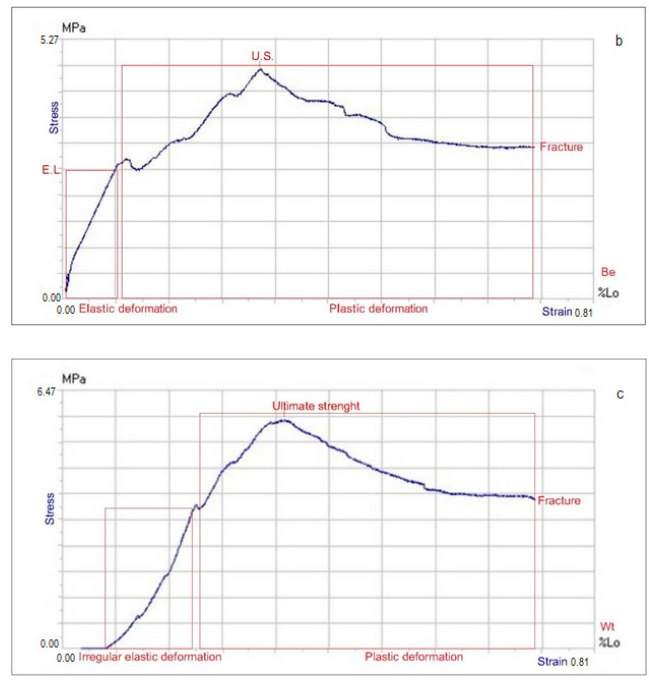
Figure 9. Stress–strain curves. ( a ) Pk; ( b ) Be and ( c ) Wt ignimbrites. E.L.: elastic limit.